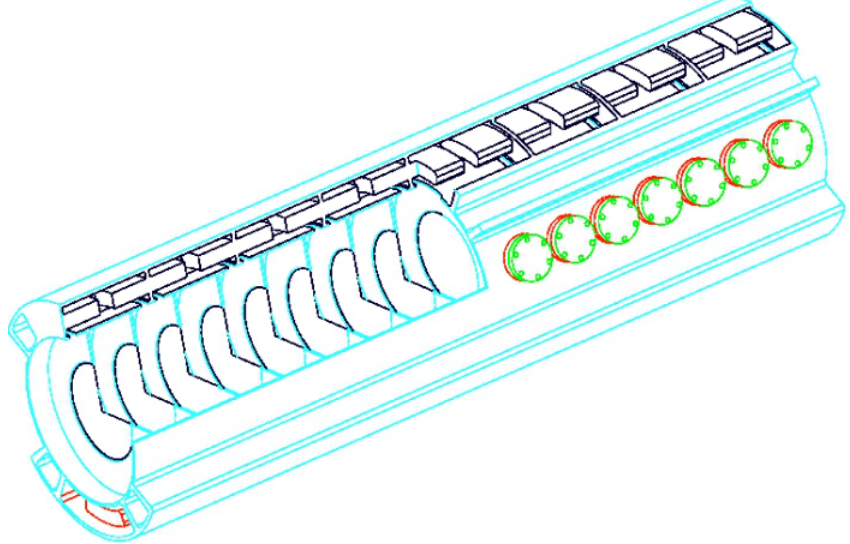
FIG. 35. (Color) A 1.3 m acceleration section with quarter section cut away for viewing the intercavity windows.